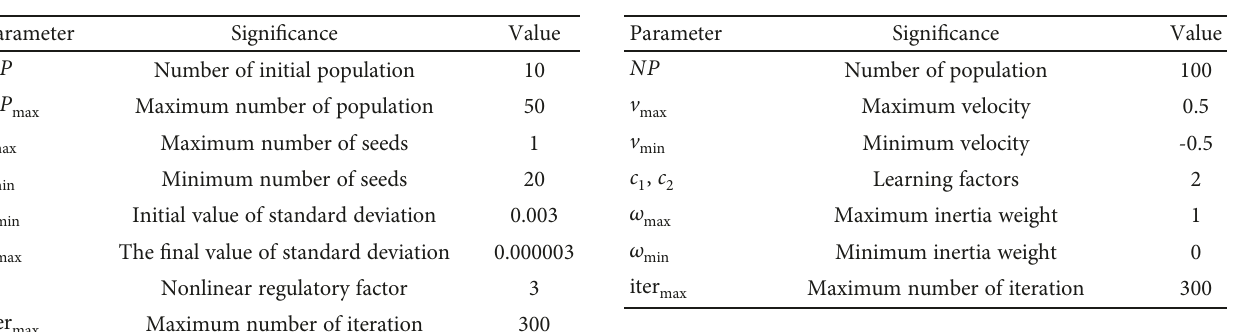
Figure 4: Rational patterns obtained by the IWO algorithm. Table 3: The parameters of the IWO algorithm. Table 4: The parameters of the PSO